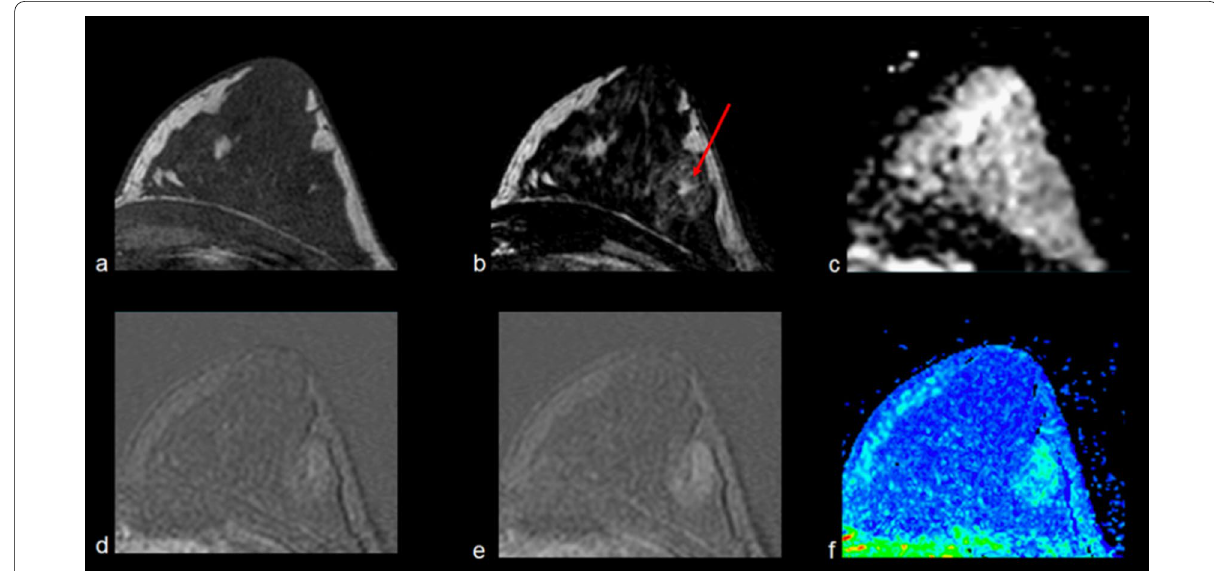
Fig. 5 Example of MRI findings of breast lesions categorized as BIRADS 4A by previous echography. A 27‑year‑old patient with a family history of breast cancer in mother and grandmother. Above: T1‑W axial ( a ), T2 VISTA axial ( b ) and ADC map ( c ) show a heterogeneous mass with a solid component in the periphery and a hyperintense central area due to a fatty component, no restricted diffusivity with an ADC of 1.9 Bottom: initial ( d ) and delayed ( e ) postcontrast subtractions, and the wash‑in map ( f ) show a progressive uptake of contrast. Morphological and kinetic features are compatible with hamartoma reported in previous echography. It was assigned as the BIRADS‑2 category